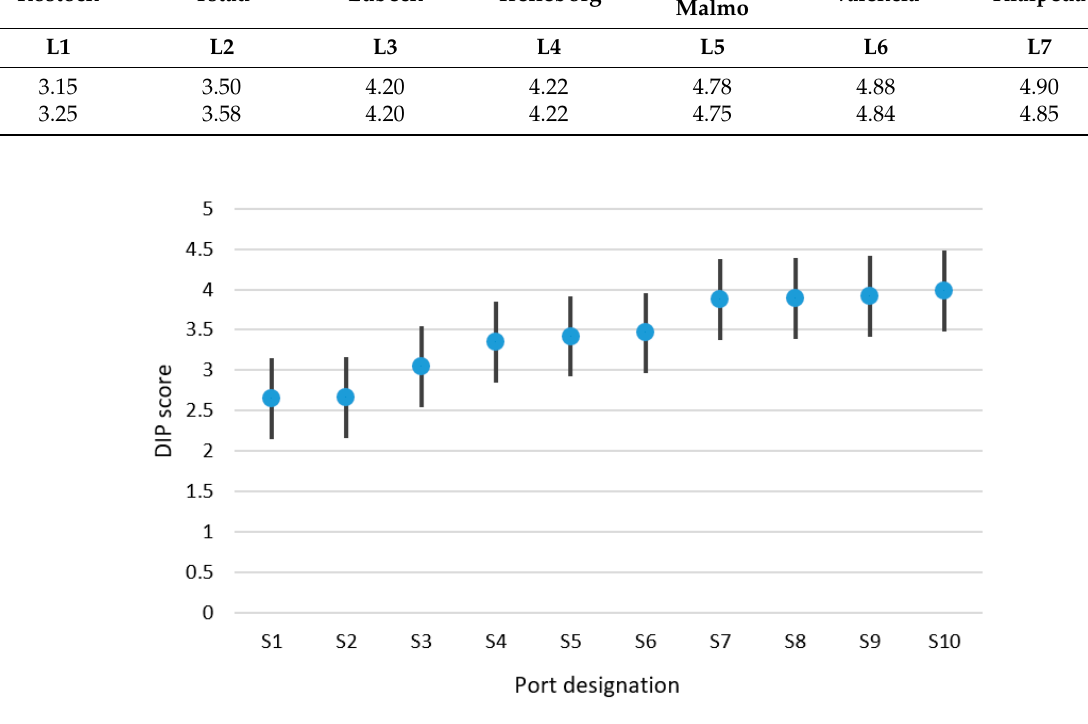
Figure 4. Small ports DIP score and DIP scoring band.